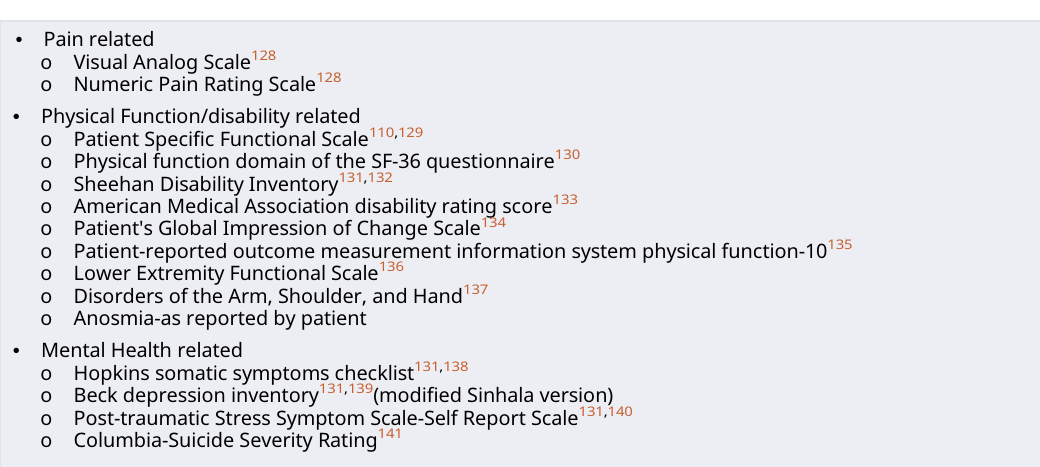
Table 3. Patient Reported Outcome Measures Reported in Snakebite